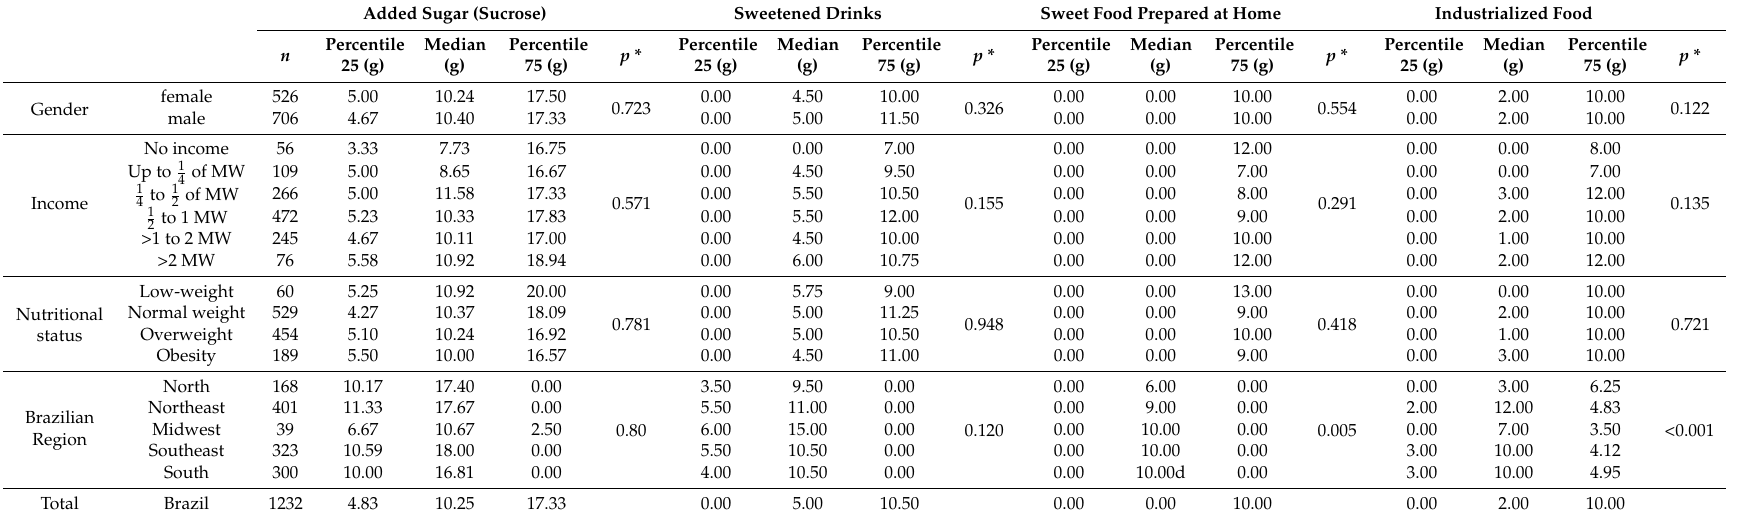
Table 1. Frequency of participants by gender, income, nutritional status, and Brazilian regions, and a comparison of median sucrose consumption (g) by sugary product